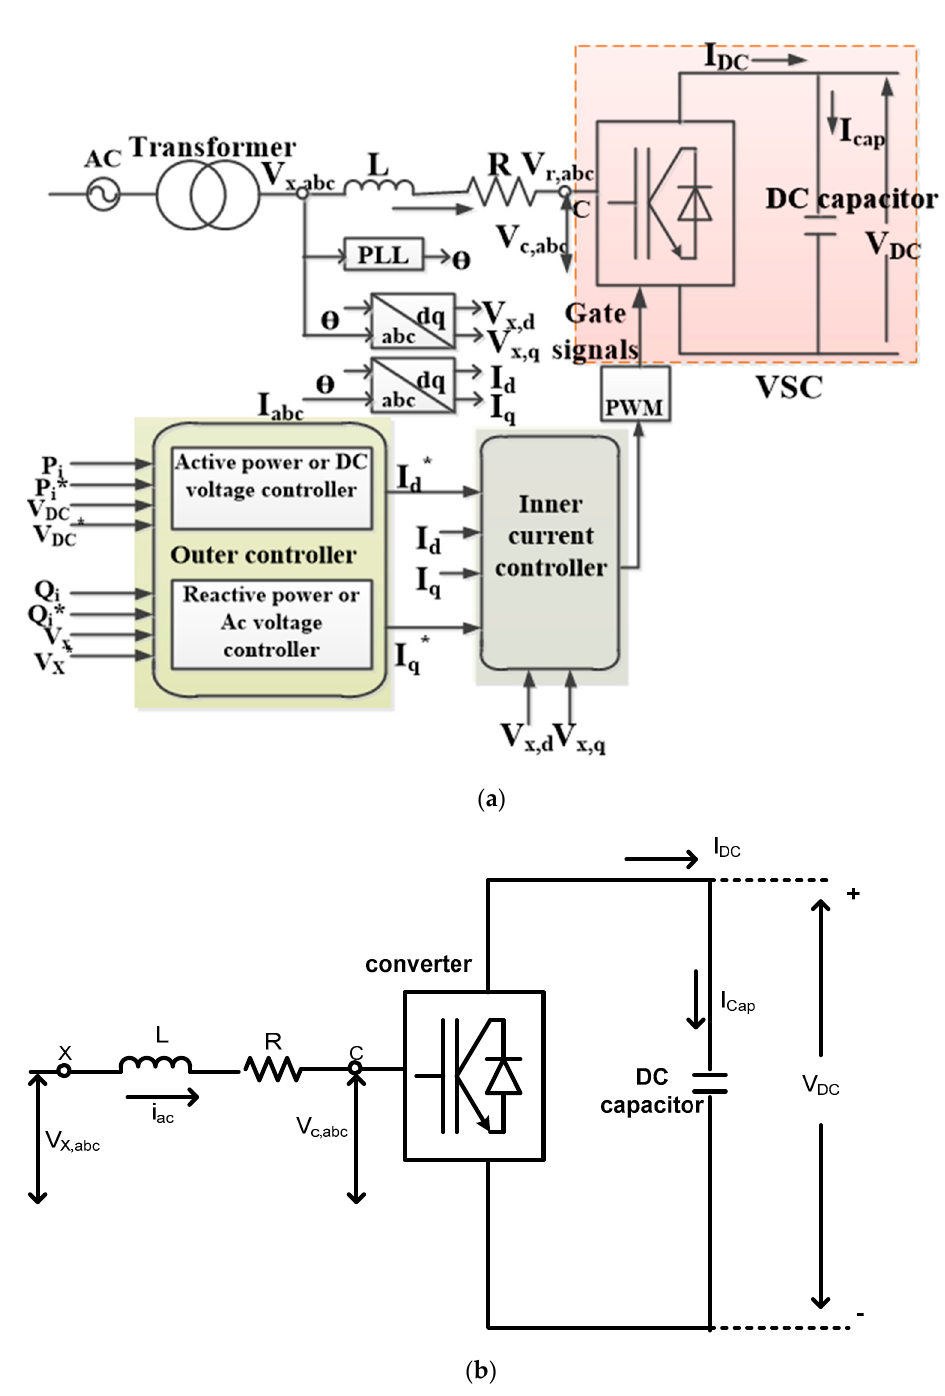
Figure 2. ( a ) Simplified structure of VSC station controllers; ( b ) schematic diagram of VSC.